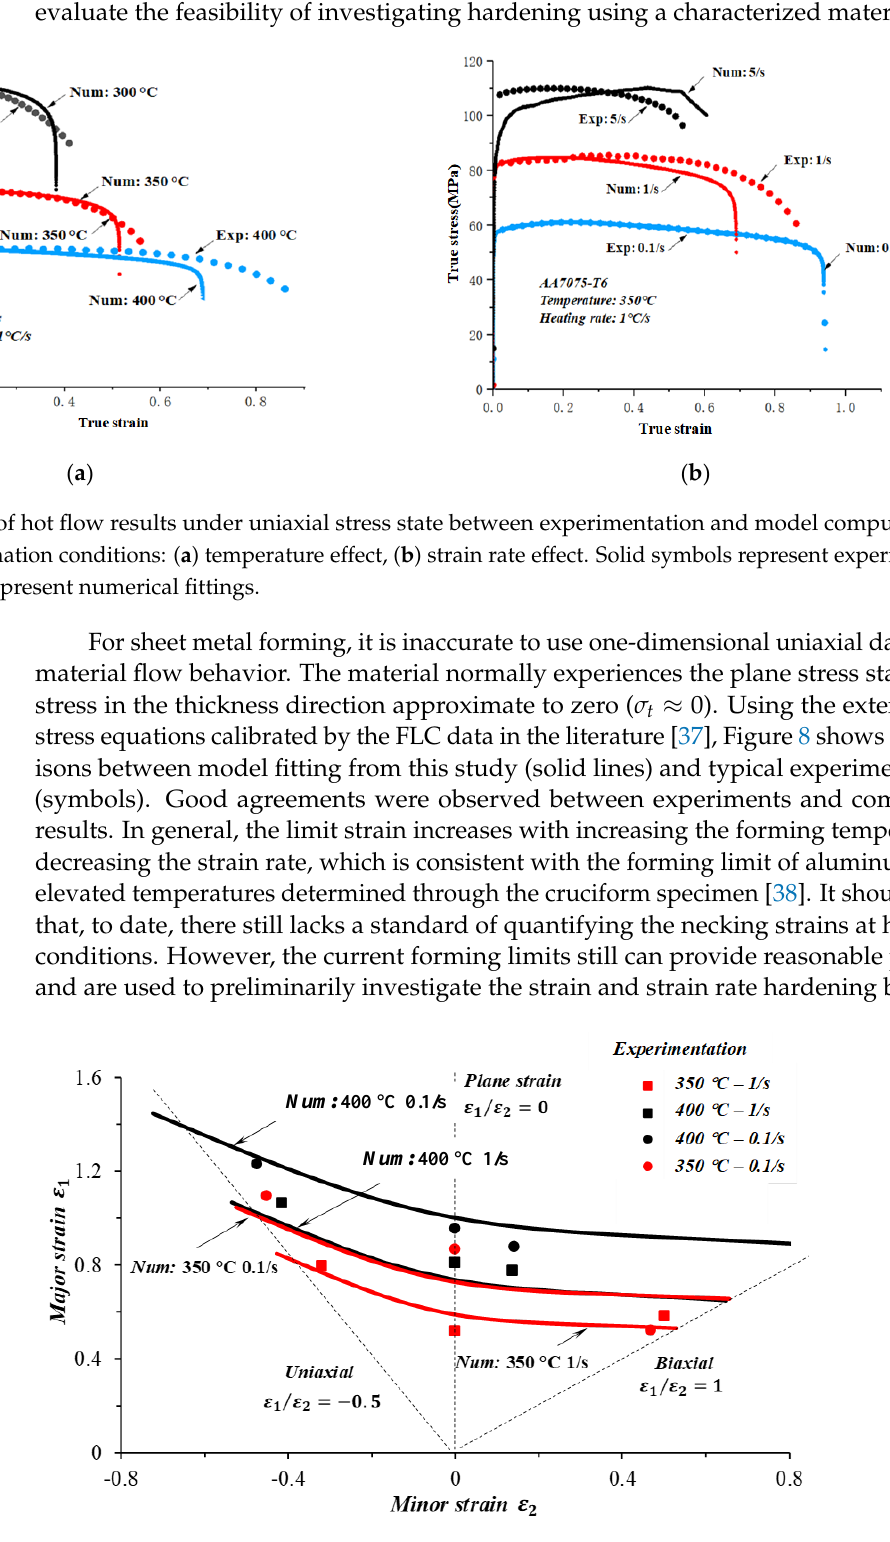
Figure 8. Comparisons of the forming limit curves (FLCs) between experimental results and 2D CDM model fittings.Solid symbols represent experimental results and solid lines represent numerical fittings.